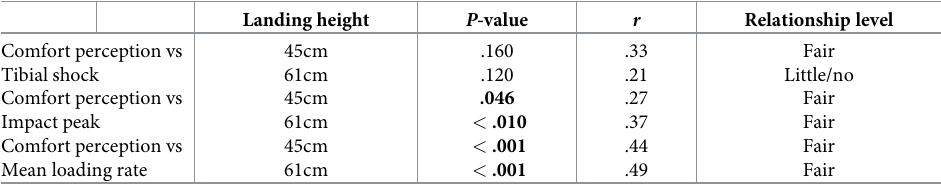
Table 2. Pearson correlation ( r ) and p -values between cushioning perception and other test variables (Table B in S1 File). Significant P -values ( P < .05) are shown in bolded. Landing